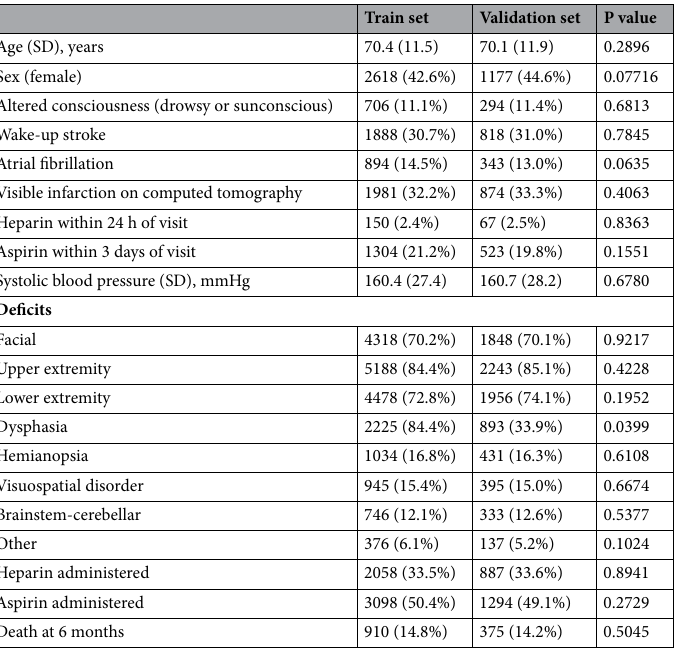
Table 1. Summary of clinical variables of train and validation sets. Tabulated data are number of patients for binary variables and mean for continuous variables. The p values are calculated with either Pearson’s χ 2 test or Student’s